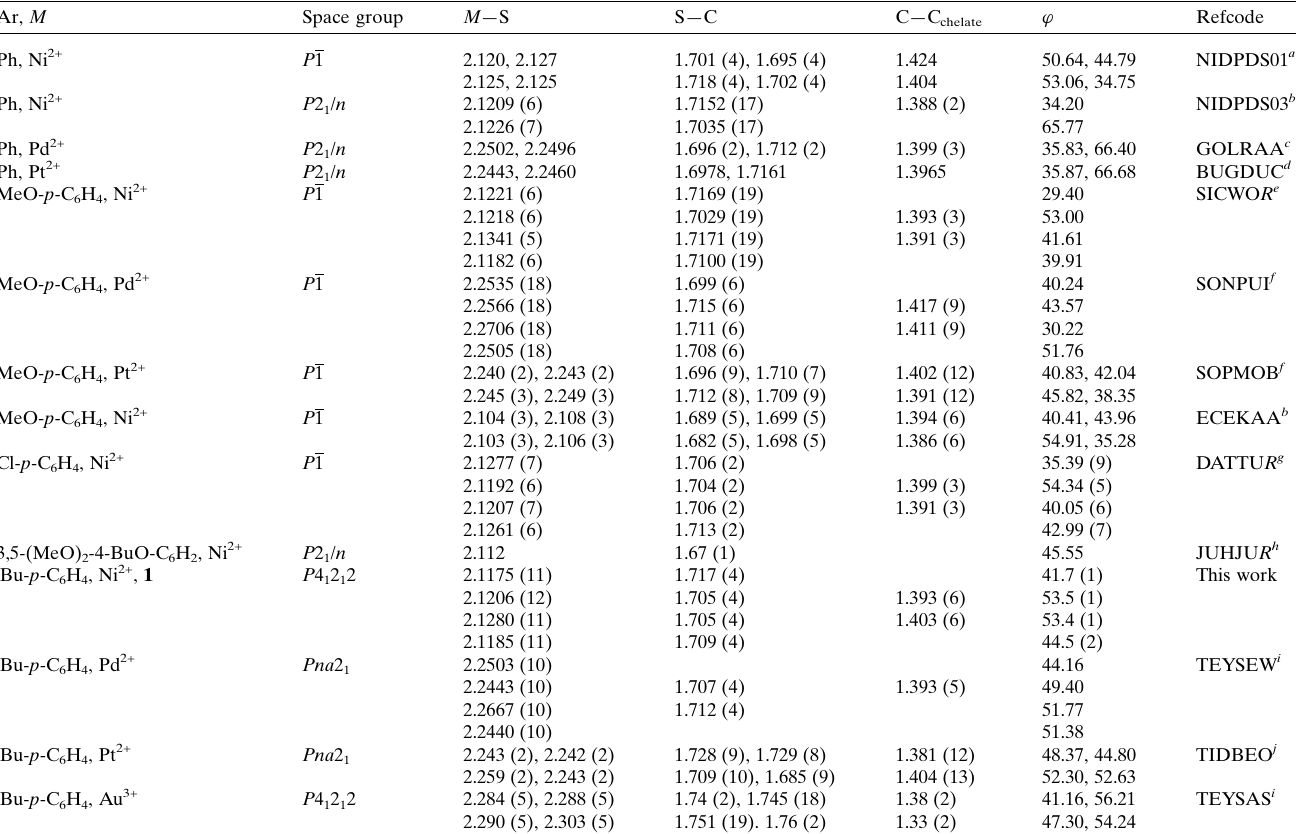
Table 1 Structural parameters (A˚ , (cid:4) ) for selected [ M (S 2 C 2 Ar 2 ) 2 ] complexes ( M = Ni 2+ , Pd 2+ , Pt 2+ , Au 3+ ; Ar = aryl group). ’ represents the angles between the M S 4 C 4 mean plane and the aryl C 6 planes. Values of ’ that were refined in SHELXL carry an uncertainty. All other values of ’ were evaluated using Mercury 3.7. Ar,